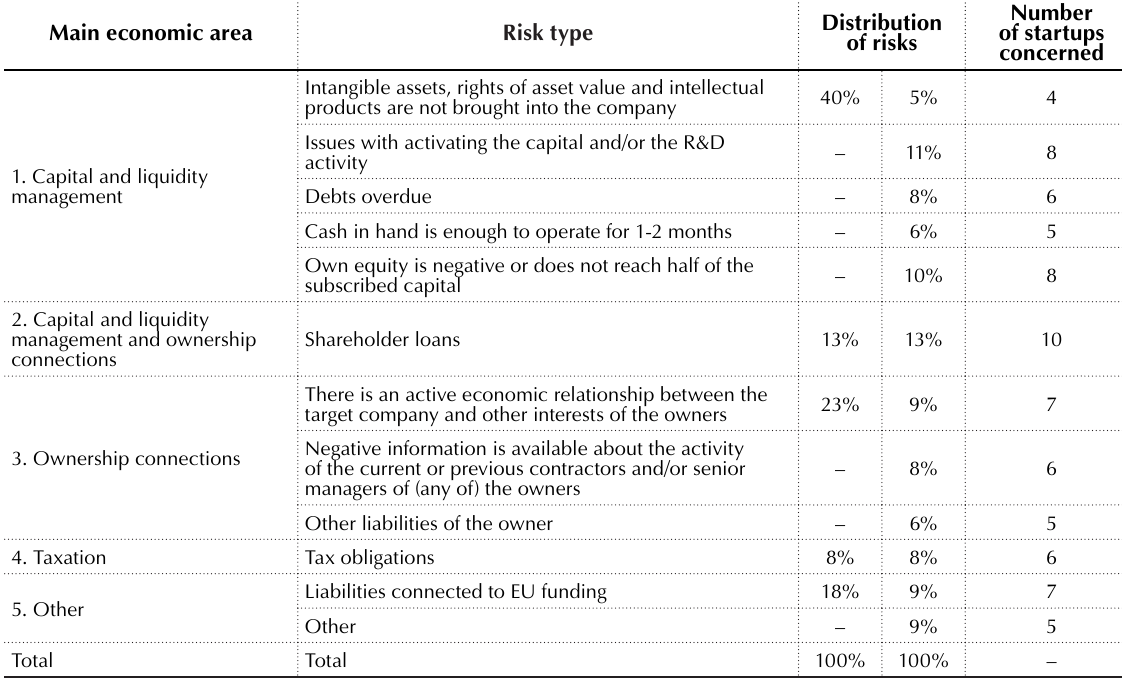
Table 2. Distribution of financial and taxation risks identified